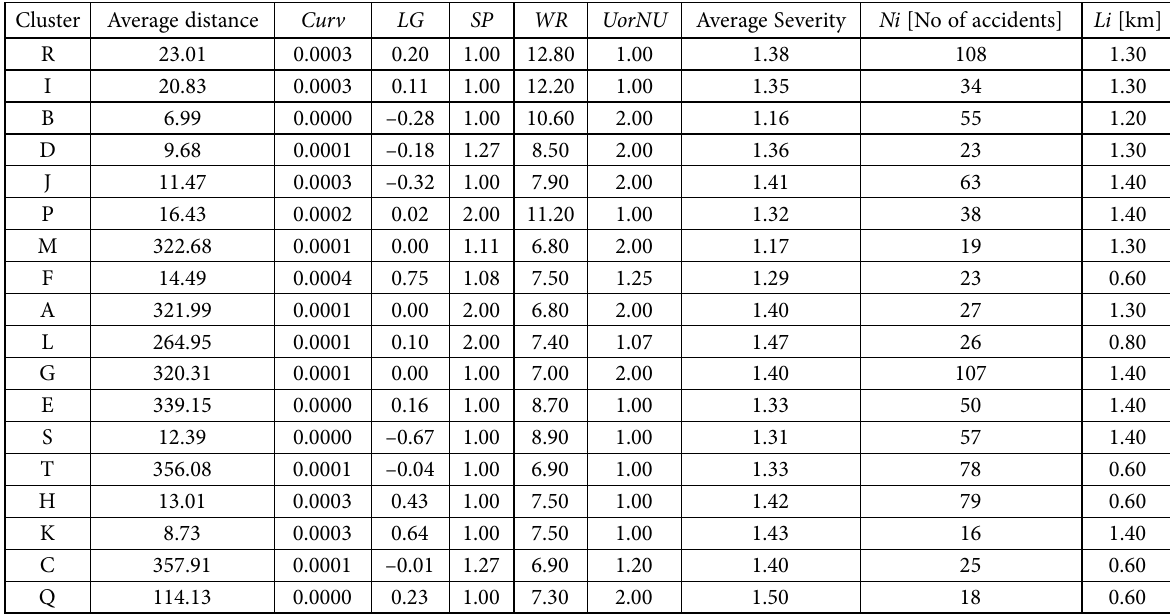
Table 3. Results obtained with the ‘hard